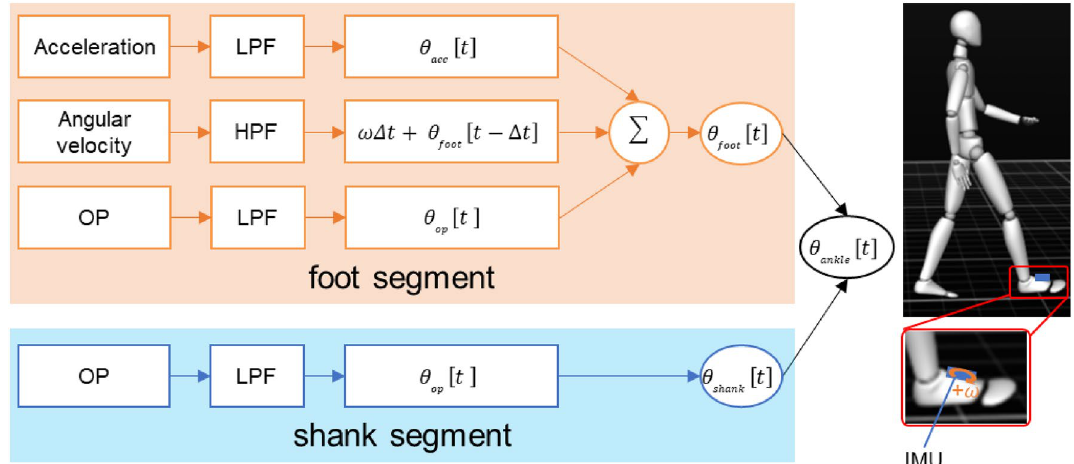
Figure 2. The proposed method fusing RGB camera-based pose estimation by OP and an IMU sensor on the foot segment to measure ankle joint angle. Foot segment angle was calculated from the acceleration, angular velocity, and OP data. LPF: low-pass filter; HPF: high-pass filter. A complementary filter was used to fuse the data based on each filter coefficients. Ankle joint angle was calculated using the fused foot segment angle and the shank segment angle from the